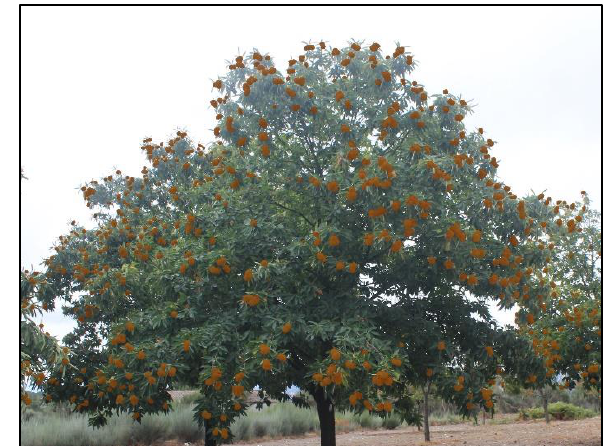
Figure 2. Example of a chestnut picture with the fruits annotated with brown blobs, manually